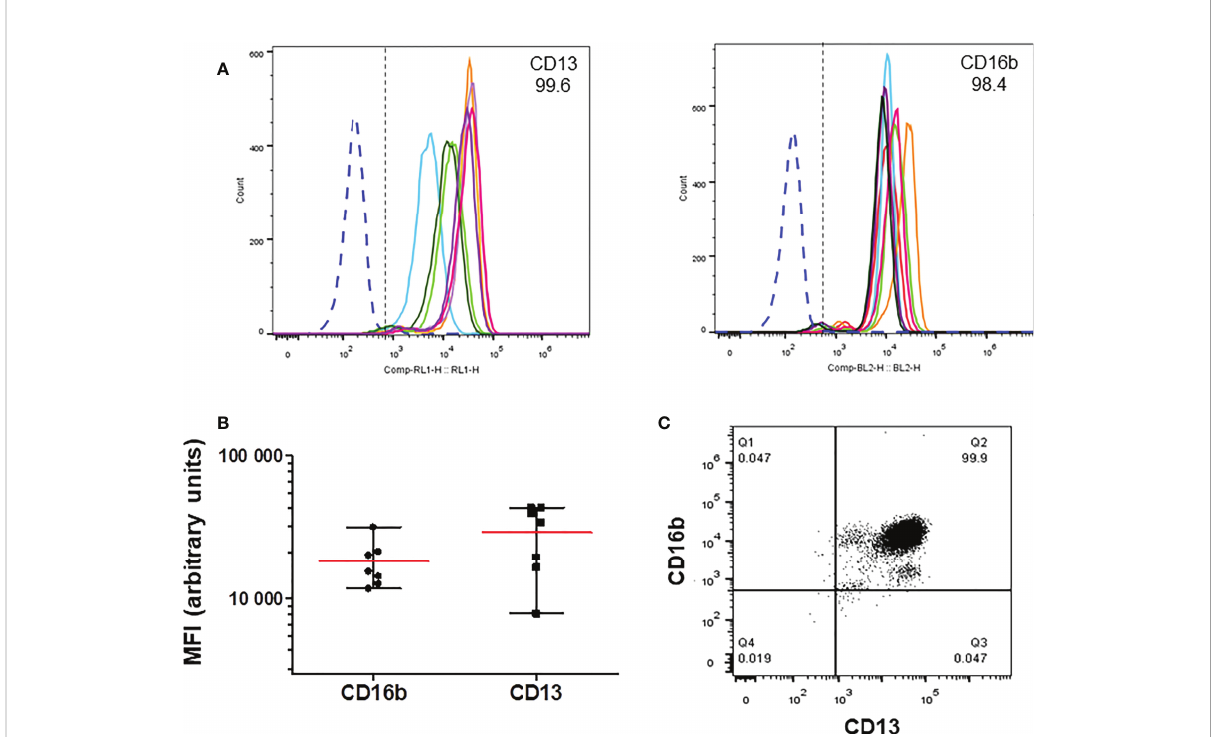
FIGURE 1 Expression of CD13 in human neutrophils. Human neutrophils were stained with anti-CD13-APC and anti-CD16b-PE, and analyzed by fl ow cytometry. (A) Representative histograms showing the expression of CD13 (left) and CD16b (right panel) in cells from individual donors. (B) Mean (± SEM) of the Mean Fluorescence Iintensity (MFI) values of the expression of CD13 and CD16b from the histograms shown in A (C) Representative dot plot of CD13 and CD16b expression in neutrophils from a single donor. More than 99.5 percent of cells express both